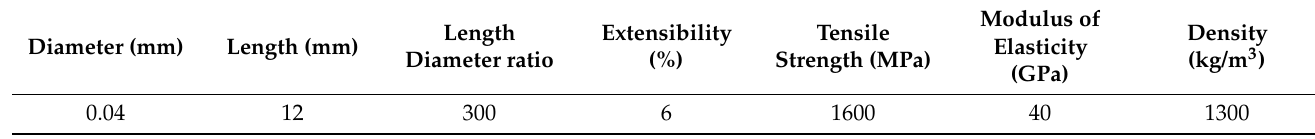
Table 2. Parameters of PVA fiber. Reproduced with permission from [Shuling Gao], [International Journal of Solids and Structures], [ELSEVIER], [2022].